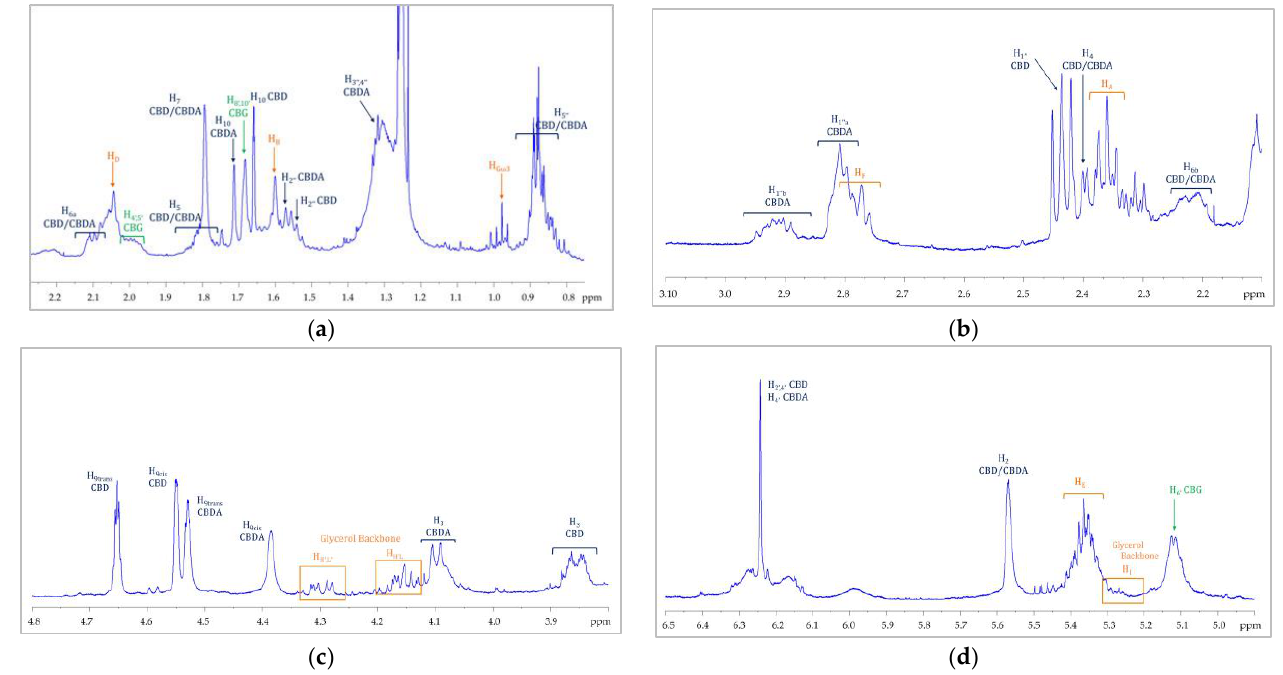
Figure 8. 1 H NMR spectrum of an ethanolic extract of C. sativa inflorescences ( Tiborszallasi variety). For the enlarged regions of ( a ) [0.8 ppm – 2.2 ppm], ( b ) [2.2 ppm – 3.00 ppm], ( c ) [3.7 ppm – 4.8 ppm], and ( d ) [4.8 ppm – 6.5 ppm] the signal attributions are shown. Signal assignments are reported with different colors: orange for TAGs; grey for the glycerol backbone; blue for CBD/CBDA; green for